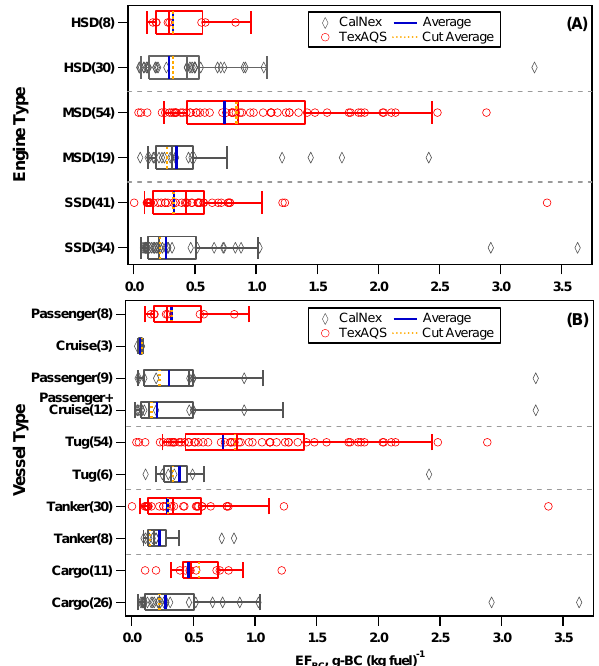
Fig. 5. Box-and-whisker plot comparing black carbon emission fac- tors by (A) engine type and (B) vessel type from the CalNex (grey) and TexAQS (red) campaigns. The open symbols are the weighted- average EF BC determined for each vessel encounter. The median EF BC ’s are the vertical lines with the same colour as the box, the geometric average EF BC ’s for a given category are indicated by the vertical blue lines, and the geometric cut-average EF BC ’s are indi- cated by the orange lines. Where the average and cut average are equal only the cut average is seen, and where the median and aver- age are equal only the median is